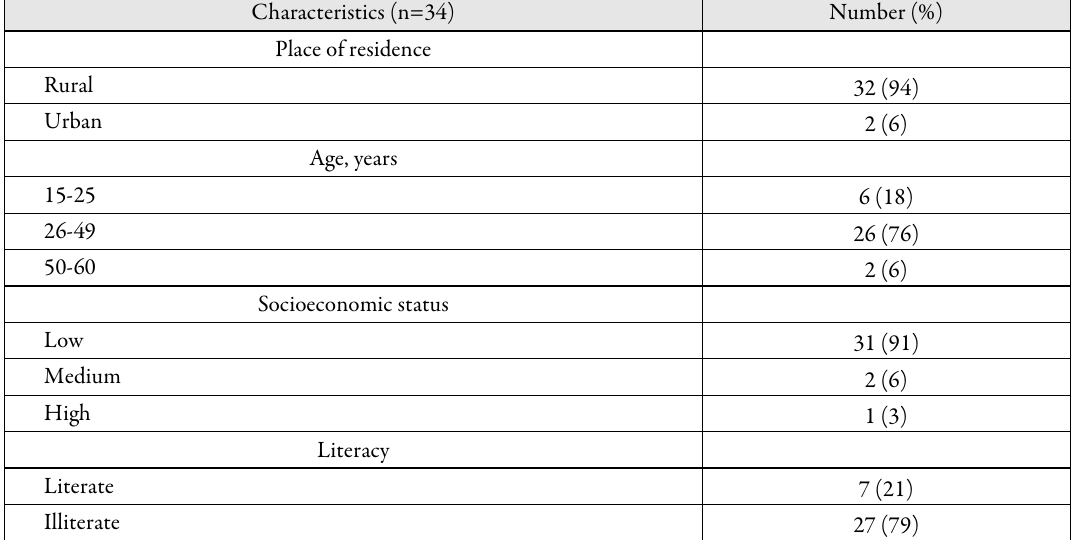
Table 1. Sociodemographic features of affected women